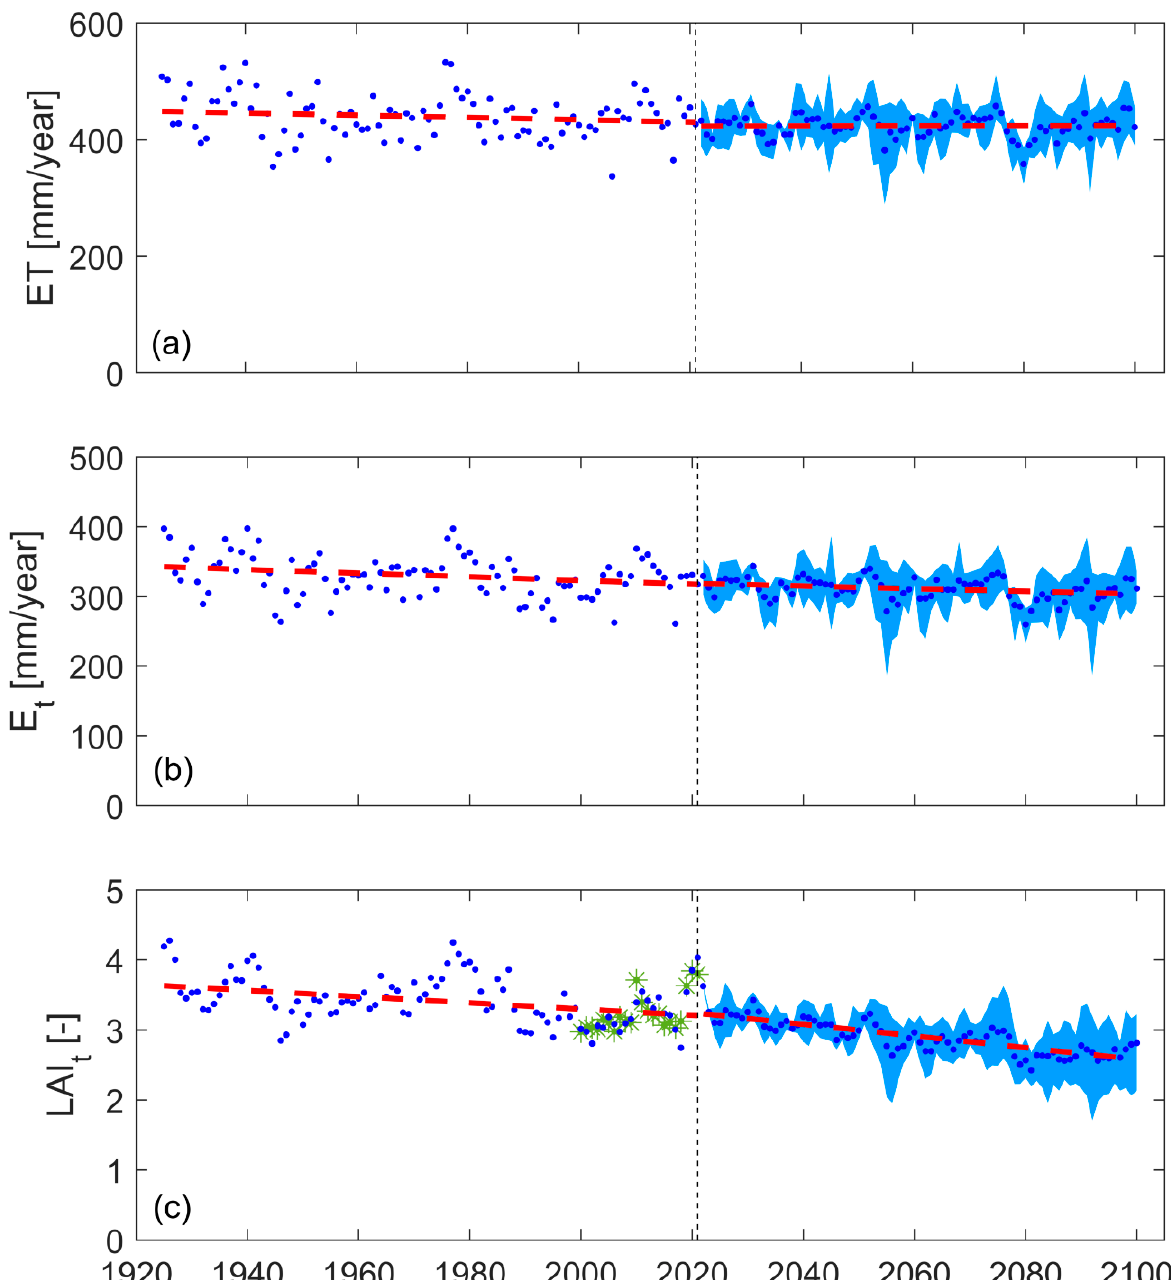
Figure 8. ( a ) Evapotranspiration (ET), ( b ) tree transpiration (E t ), and ( c ) tree LAI (LAI t ) predictions using the meteorological observations of the Sardinian meteorological network (up to 2021), and the future climate scenarios of the HadGEM2-AO model (up to 2100). The slopes of the trend lines (red dashed) are estimated by the Theil − Sen method. For the future period, blue dots represent the mean of the four representative concentration pathways (RCP 26, RCP 45, RCP 60, RCP 85), and the shaded light blue areas around the mean bound the minimum and maximum values of the scenarios. For LAI t , green asterisks are the estimated values from NDVI of the MODIS remote sensor.